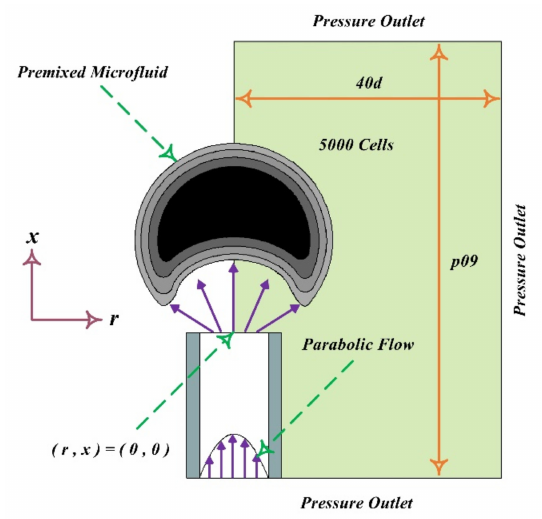
Figure 23. Computational domain [224].